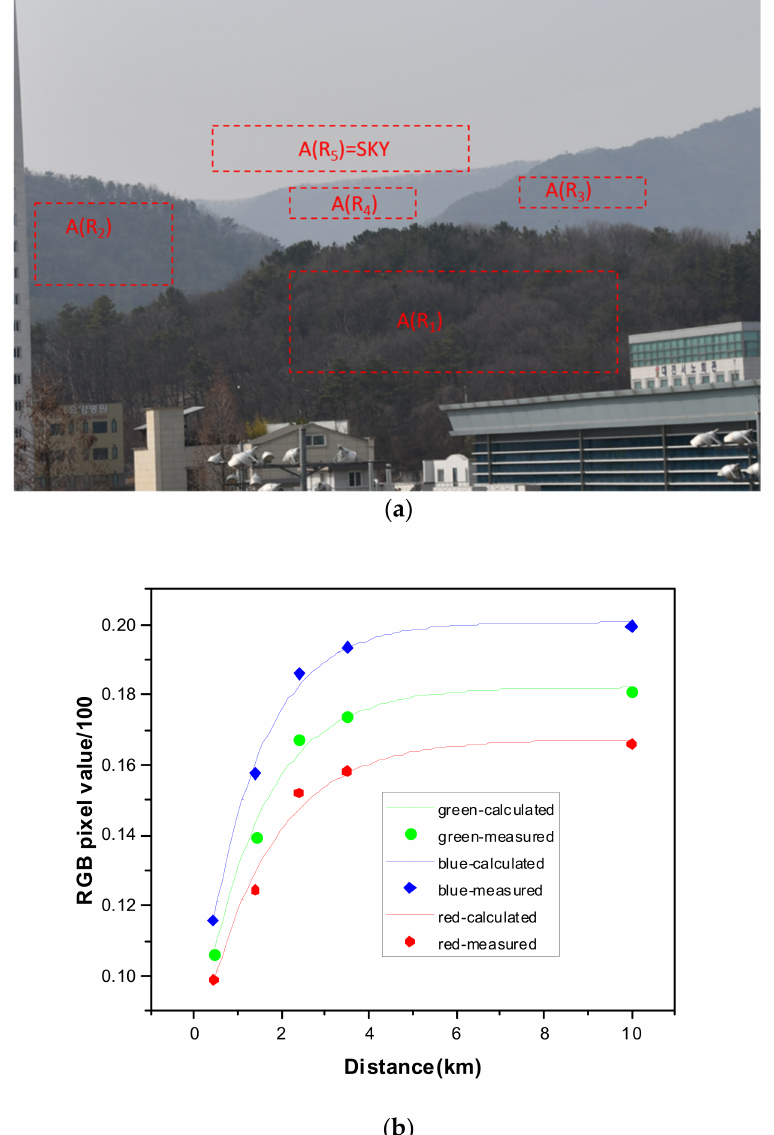
Figure 1. Traditional landscape image and exponential curve shapes when using five different objects, including sky images (438 m, 1.4 km, 2.4 km, 3.5 km, and an assumed 10 km). ( a ) Landscape image and five target objects and ( b ) pixel values and the fitted exponential